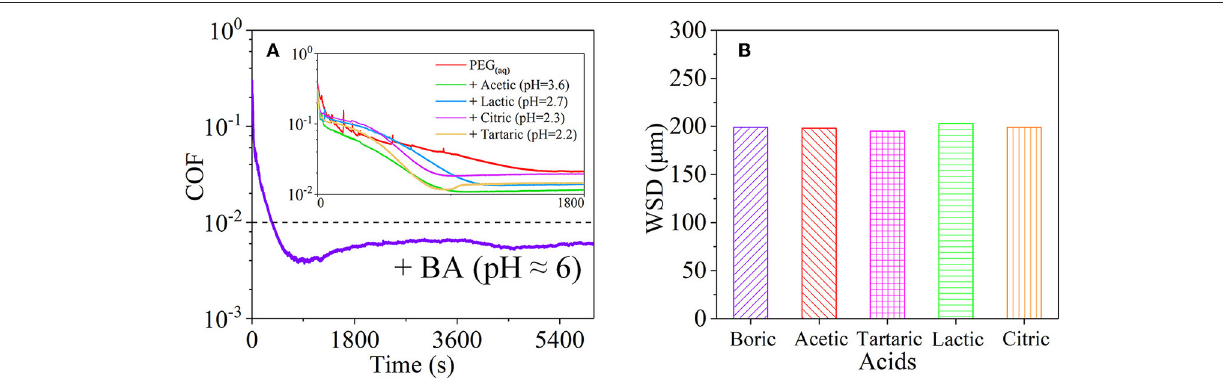
FIGURE 8 | (A) COFs and (B) wear scar diameter (WSD) of the mixtures of PEG and several acids: BA, acetic acid, tartaric acid, lactic acid, and citric acid. Ge et al. (2018a) Copyright 2018, American Chemical